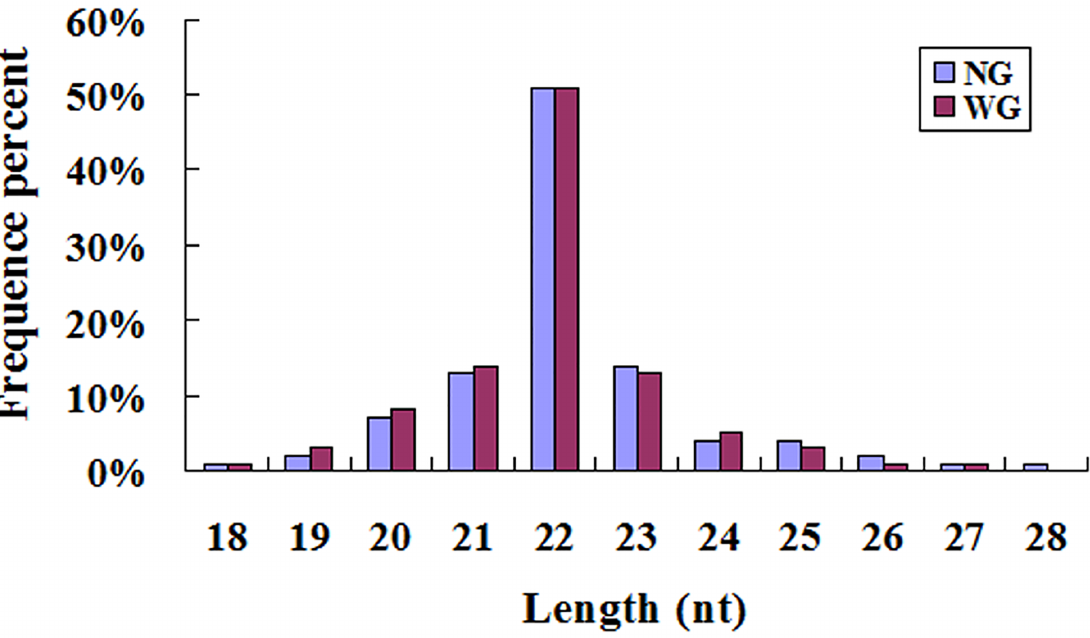
Fig 1. Length distribution of small RNAs sequences in NG and WG